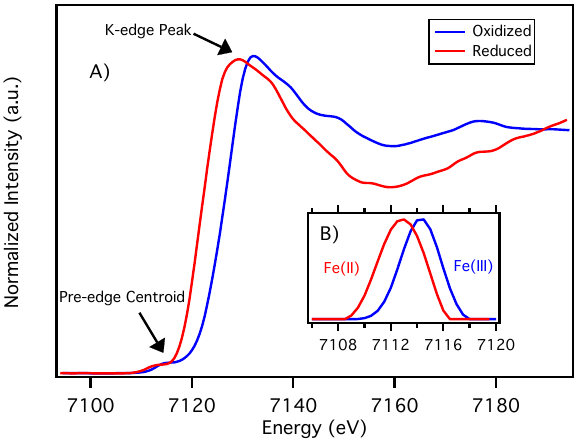
Fig. 3. (A) XANES spectra of a representative oxidized particle (blue line) and reduced Fe particle (red line) (B) Example of the normalized pre-edge centroid position of a representative oxidized particle (blue line) and reduced particle (red